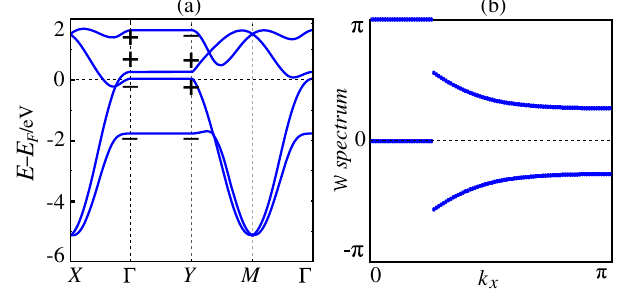
FIG. 6. (a) Band structure for the tight-binding model [Eq. (7)] of spin-orbit-free WTe 2 , with parameters listed in Appedix C. At Γ and Y , þ and − , respectively, label bands with screw eigenvalues þ 1 and − 1 . (b) Phases of the Wilson-loop eigen- values, as calculated for the same tight-binding model [Eq.